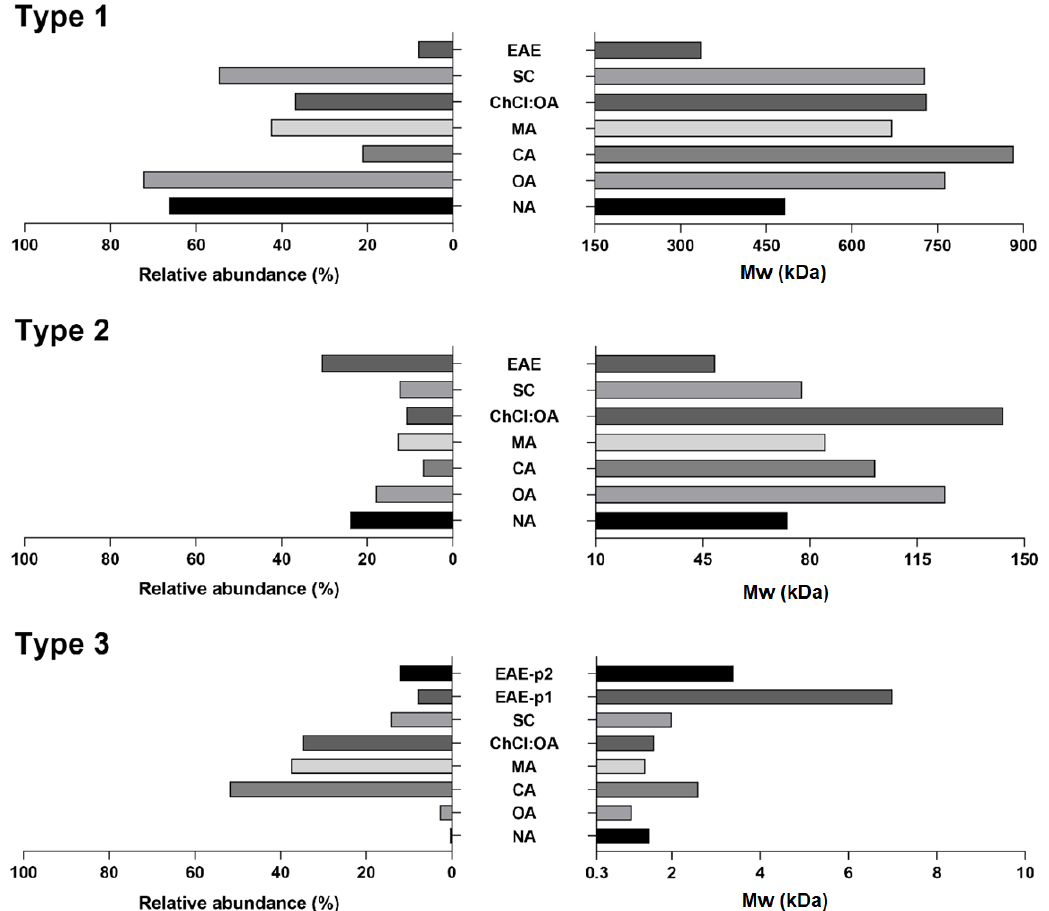
Figure 2. Average Mw values (kDa) and relative abundances (%) of the main type of fragments detected in the pectin samples under study. NA (Nitric Acid), OA (Oxalic Acid), CA (Citric Acid), MA (Malic Acid), ChCl/OA (DE Choline Chloride/Oxalic Acid), SC (Sodium Citrate), EAE (Enzymatic-Assisted Extraction), p1 (peak 1), p2 (peak 2).